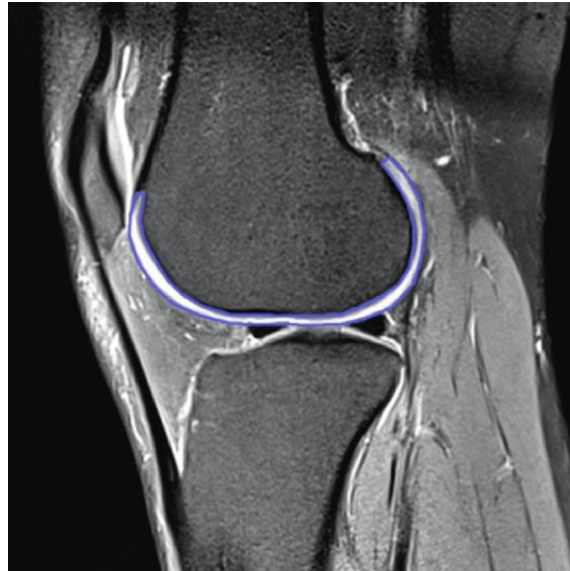
Figure 5: Manual segmentation of femur